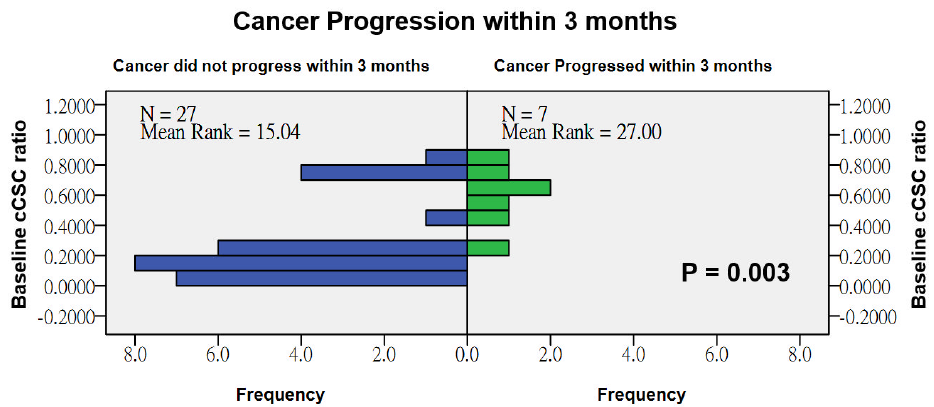
Figure 5. The presence of circulating cancer stem-like cells (cCSCs) could predict rapid disease progression within 3 months ( p = 0.003 based on the Mann-Whitney U test).